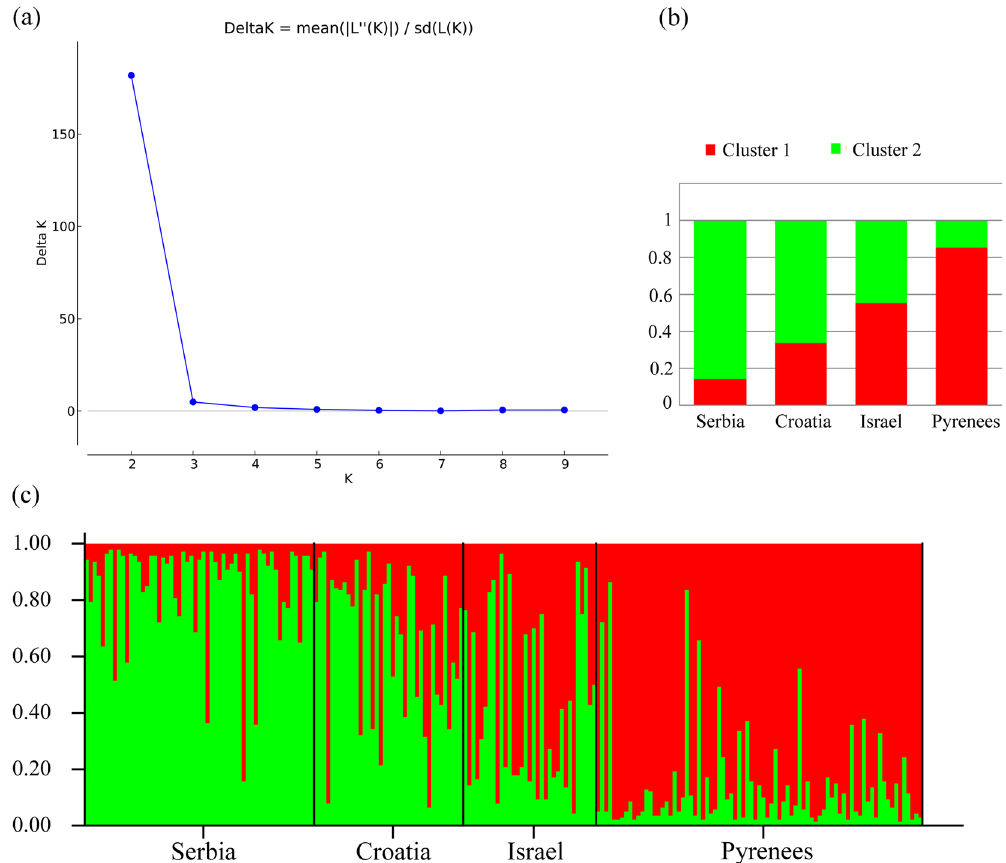
Figure 3. ( a ) Delta K values for the assumed number of genetic clusters. ( b ) Proportions of inferred STRU CTU RE clusters ( K = 2) from the native populations. ( c ) Proportions of the inferred STRU CTU RE clusters ( K = 2) from the